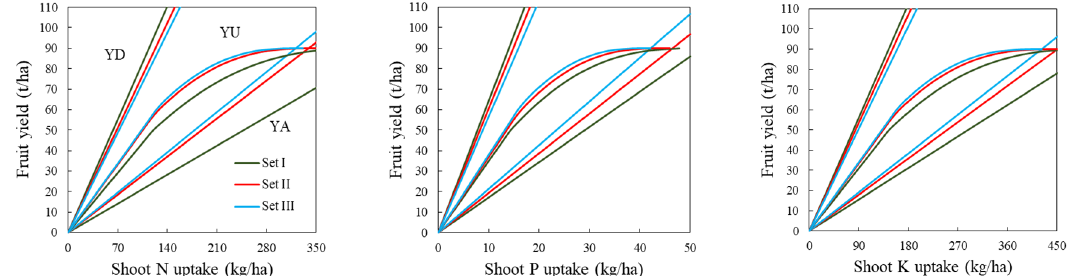
Figure 3. Relationships between fruit yield and nutrient uptake of watermelon at different sets of constants a and d . Set I, II, and III excluded the upper and lower 2.5th, 5.0th, and 7.5th percentiles of all internal efficiency (IE) data, respectively. YD, YA, and YU represented the maximum dilution, maximum accumulation, and balanced uptake of N, P, or K in the shoot, respectively. The yield potential was set at 90 t/ha. Table 6. Envelope coefficients relating fruit yield to the maximum accumulation ( a ) and maximum dilution ( d ) of N, P and K in the shoot dry matter of all watermelon. Constants a and d were calculated by excluding the upper and lower 2.5th (set I), 5.0th (set II), and 7.5th (set III) percentiles of all nutrient efficiency data of the combined dataset.